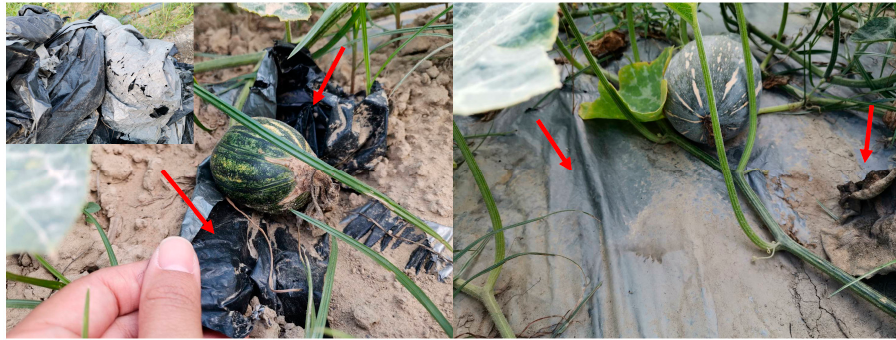
Figure 6. Extensive application of plastic mulch in farm D, cultivated by